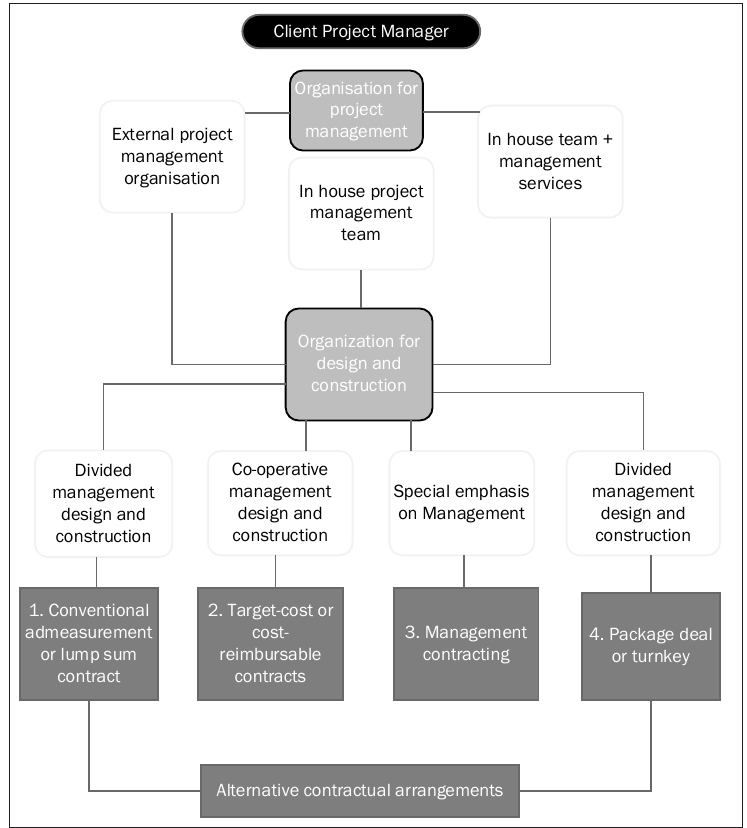
Figure 1: Characteristics of different categories of construction contracts Source: Loots, 1995: